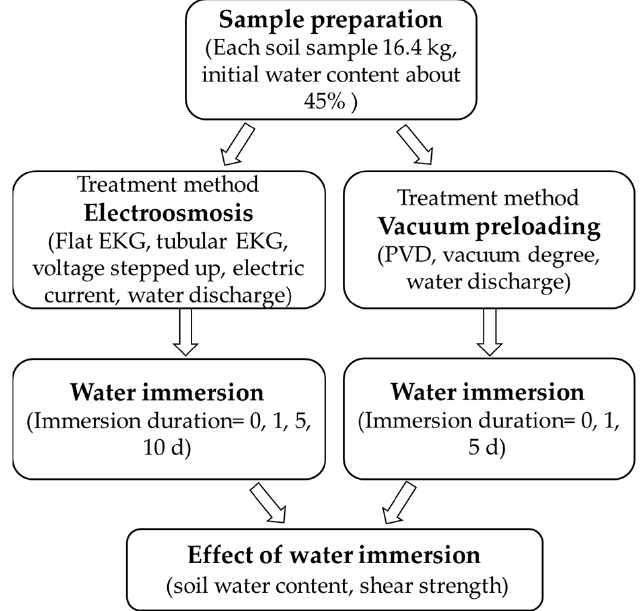
Figure 4. Flow chart of the testing program.